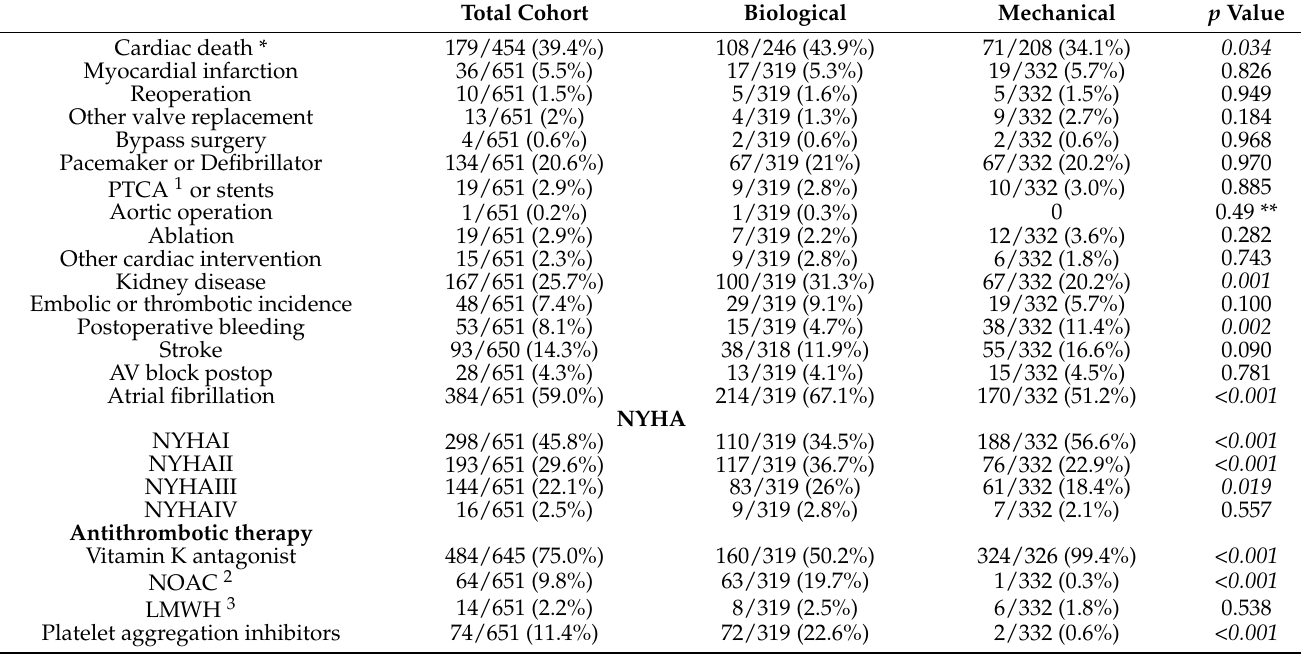
Table 3. Postoperative